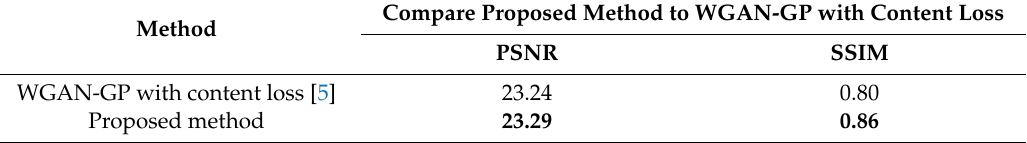
Table 4. PSNR and SSIM on Kohler dataset.